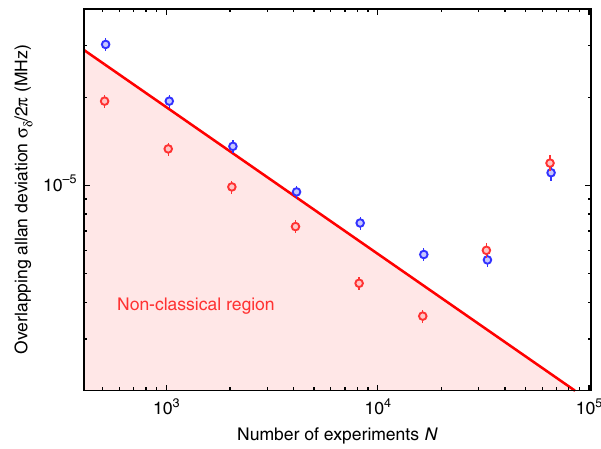
Fig. 4 Evaluation of trapping frequency measurement. Overlapping Allan deviation for frequency measurement with a coherent state (blue circles) and with a n = 1 displaced Fock state (red circles). The solid line shows the quantum projection noise limit from Eq.